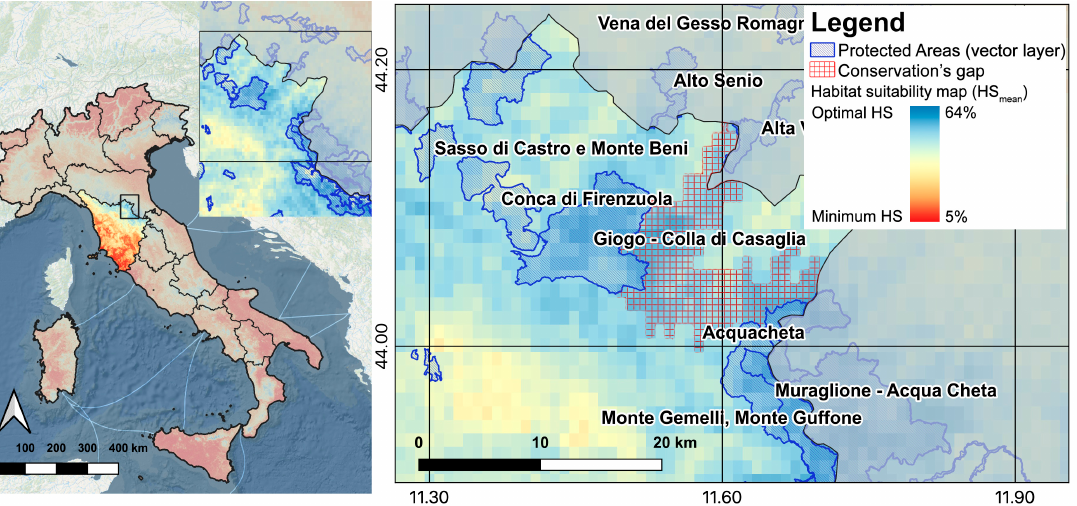
Figure 5. Map showing the habitat suitability hotspot in northern Apennines of the Tuscany region. The area marked by red squares indicates the conservation gap highlighted by overlaying the national protected area boundaries to the HS mean map of the big five .